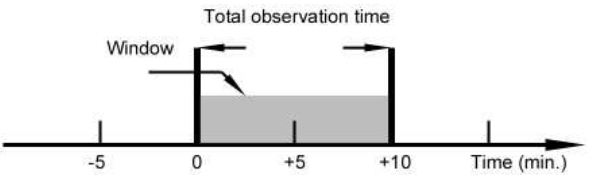
Fig. 2. Temporal window used for computing the distributions of diffusion coefficient and correlation time. The time (here + 5min) is defined at the center of the